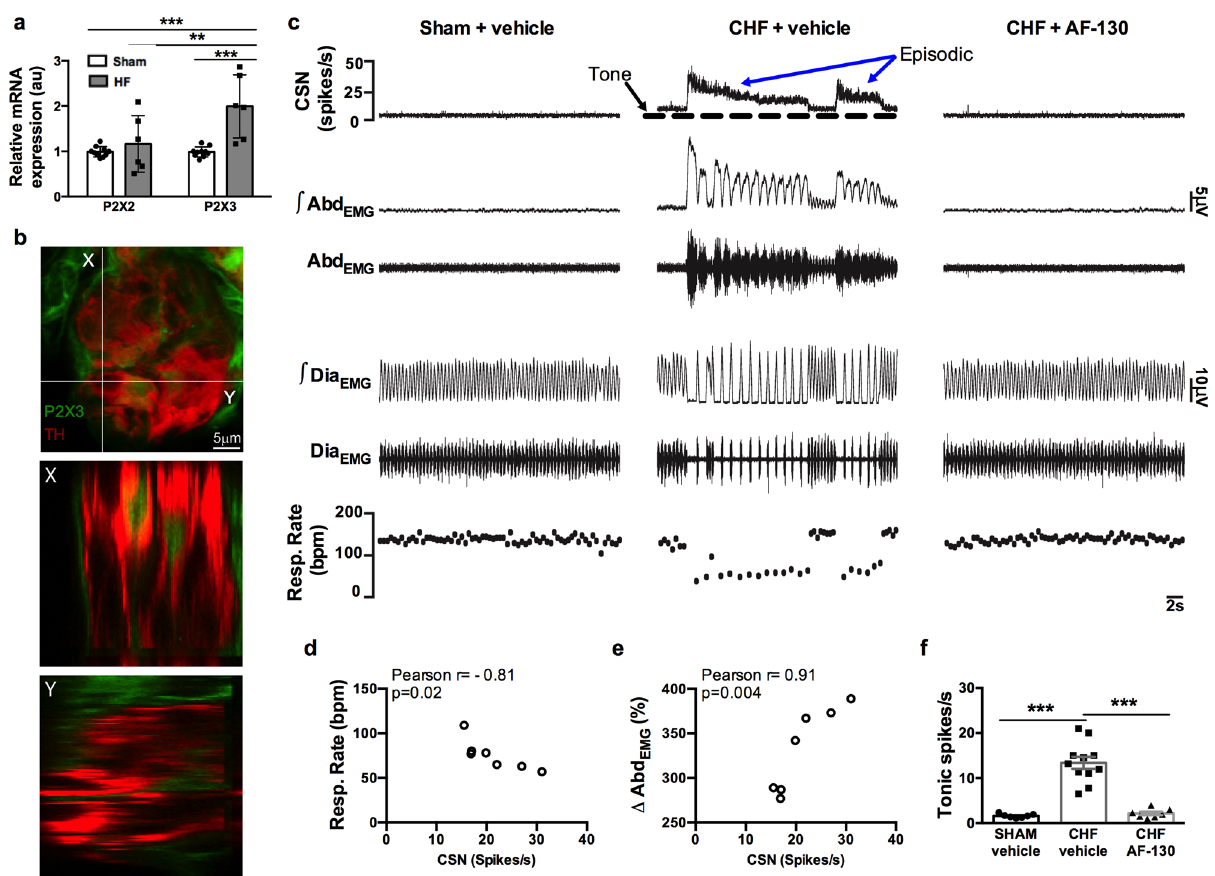
Fig.1|Episodiccarotidsinusnervedischargeinchronicheartfailure(CHF)rats is mediated by P2X3 receptors and causes respiratory disturbance via activa- tionofactiveexpiration.a RT – qPCRindicatedupregulationofP2X3butnotP2X2 receptors in the petrosal ganglion chemoreceptive neurons from HF rats. β